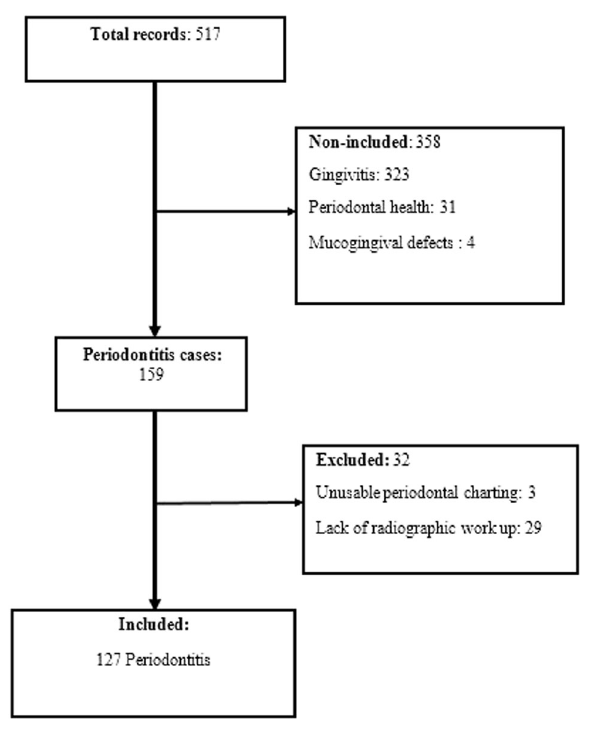
Fig. 1 Flow chart. Showing the number of periodontitis cases during the selection